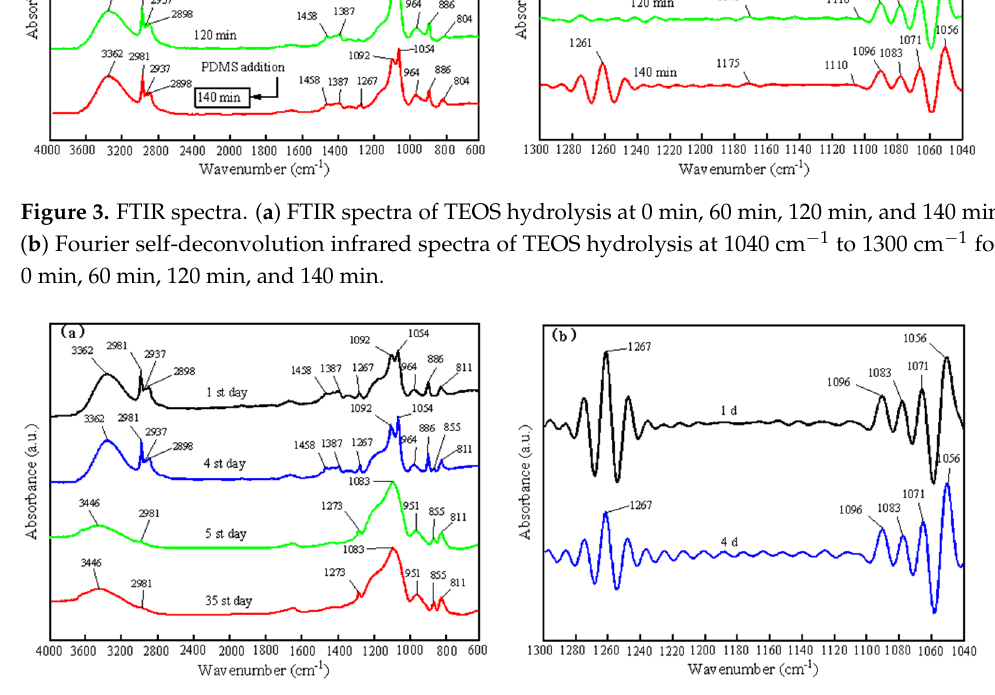
Figure 4. FTIR spectra. ( a ) FTIR spectra of sol-gel curing at 1, 4, 5, and 35 days. ( b ) Fourier self- deconvolution infrared spectra of sols cured at 1040 cm − 1 to 1300 cm − 1 for 1 and 4 days. The results of the FTIR analysis indicated that the formation of SiO 2 -TiO 2 -PDMS coat- ing can be roughly divided into three stages. The first stage mainly included the hydroly- sis and condensation of TEOS. In the second stage, when the hydrolysis and condensation reaction of TEOS reached a certain degree, TEOS and PDMS co-polymerized. At this point, the long chains of PDMS broke apart and oligomers were produced. In the third stage, after the nano-hybrid sol was applied to the surface of the building wall, the co-polymer- ization reaction between TiO 2 and PDMS occurred within the SiO 2 network, resulting in the formation of a uniform organic-inorganic hybrid gel five days later. The related chem- ical [56] reactions are shown in Equations (3)–(8).